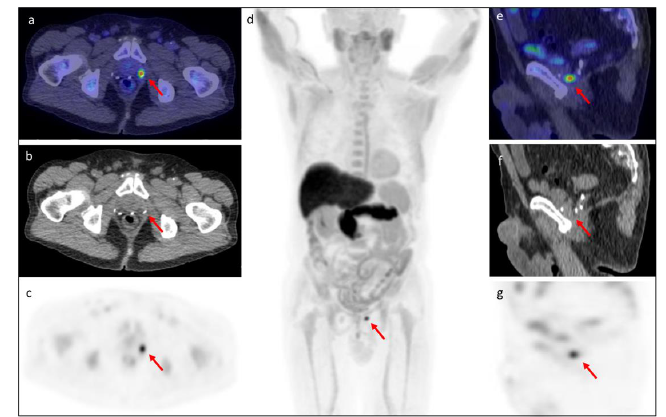
Figure 3. [ 18 F]fluciclovine PET/CT performed in a 75-year-old patient with BCR after radical prosta- tectomy (Gleason Score 7 = 4 + 3). At the time of the PET/CT, PSA rose to 0.89 ng/mL with PSAdt of 7.8 months. The (d) MIP, (a – c) axial (a: fused PET/CT, b: CT, c: PET) and (e – g) sagittal (e: fused PET/CT, f: CT, g: PET) images showed a locoregional recurrent lesion in left prostatectomy bed (red arrow) with SUVmax 8.6.